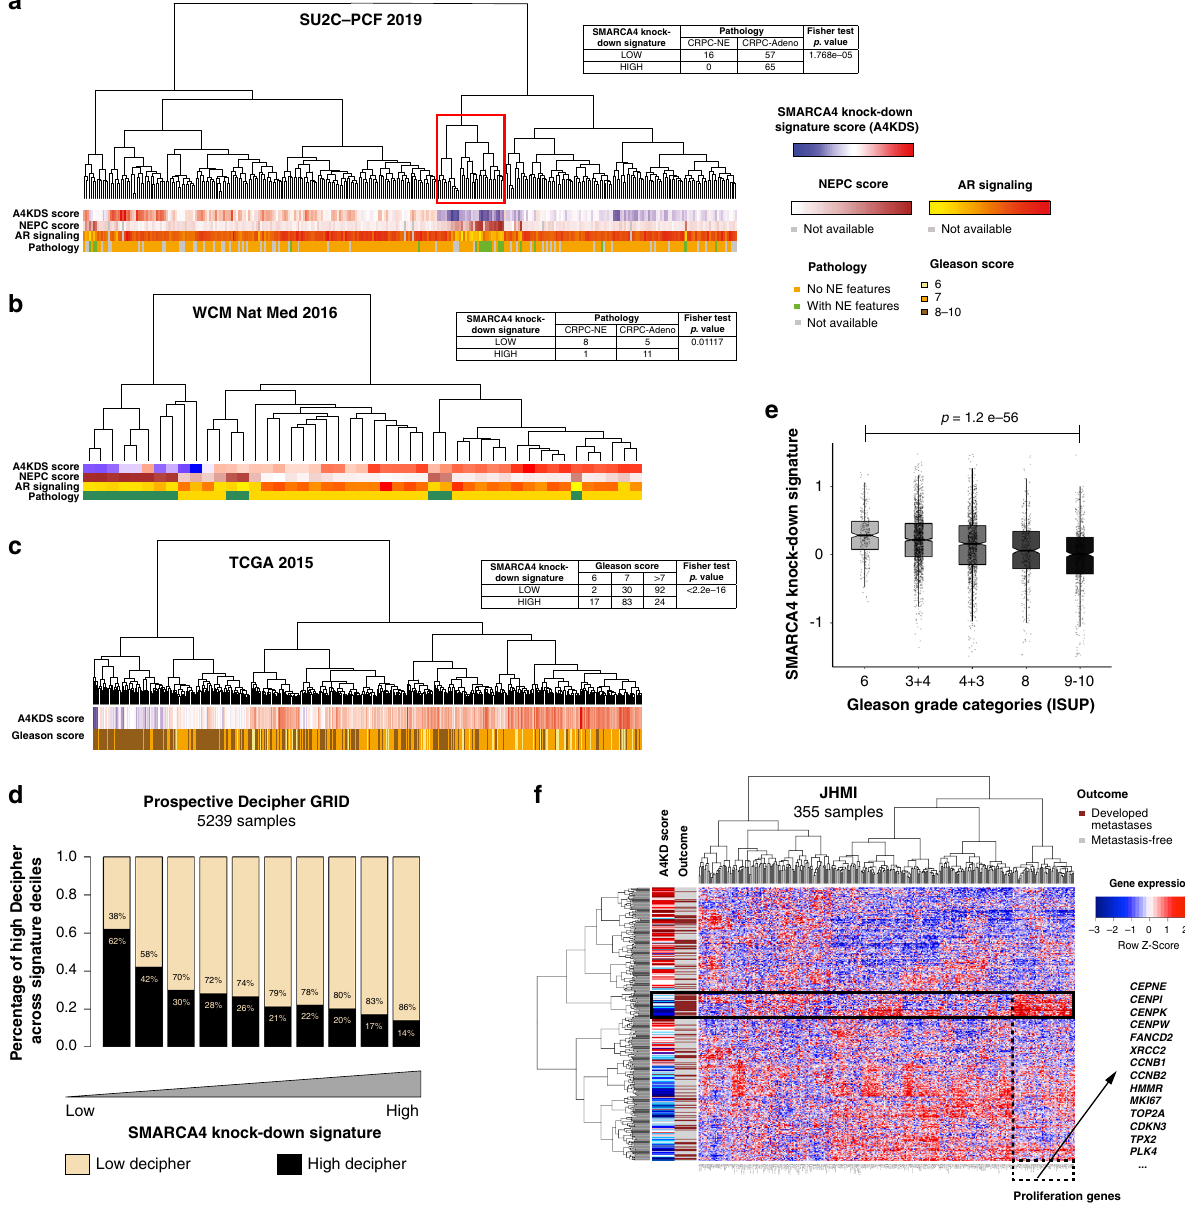
Fig. 3 Transcriptomic SMARCA4 knock-down signature in PCa cohorts. a 332 cases of CRPC from the SU2C-PCF cohort (table: n = 138). b 47 cases of CRPC from the WCM cohort (table: n = 25). c 495 cases of localized PCa from the TCGA cohort (table: n = 248); p value = 1.21e − 18 ( a – c represent two- paired tests). d Low SMARCA4 knock-down signature scores are associated with high Decipher scores (surrogate for risk of metastasis) in 5239 primary PCa samples from the Prospective Decipher GRID (Mann – Whitney U test). e Low SMARCA4 knock-down signature scores are associated with higher Gleason score in the same Decipher GRID cohort (Mann – Kendall trend test). The center of each boxplot represents the mean, lower bound represents the 25th percentile, the top bound represents the 75th percentile, the whiskers represent the 95% CI. p value = 1.2e − 56. f Unsupervised clustering of patients from in the JHMI natural history PCa cohort (Johns Hopkins Medical Institute, n = 355) based on the downregulated genes from the SMARCA4 knock- down signature, and compared to metastatic outcome (brown: metastatic recurrence, gray: metastasis-free). Overexpression of a subset of genes, many of which are related to proliferation, is seen in a cluster of patients who presented metastatic outcome (black or 100%) than in CRPC-Adeno cases ( n = 57 or 46.7%) ( p = examined two CRPC cohorts consisting of 332 patients from the 1.77e − 05) (Fig. 3a). A similar result was obtained in the WCM Stand Up To Cancer-Prostate Cancer Foundation (SU2C-PCF) cohort ( n = 25): low SMARCA4 knock-down signature scores trial treated with ARSi 5 and 47 patients from the Weill Cornell were seen in 89% ( n = 8) of CRPC-NE cases vs. 31% ( n = 5) of Medicine (WCM) cohort 4 . In the SU2C-PCF cohort, when considering patients from the highest (top 25%) and lowest CRPC-Adeno cases ( p = 0.011) (Fig. 3b). Furthermore, low (bottom 25%) quartiles of SMARCA4 knock-down signature SMARCA4 knock-down signature was associated with a higher scores ( n = 138), low SMARCA4 knock-down signature scores NEPC 4 and a lower AR signaling score 35 in both cohorts were signi fi cantly more often observed in CRPC-NE cases ( n = 16 (Supplementary Table 2). One particularly informative cluster